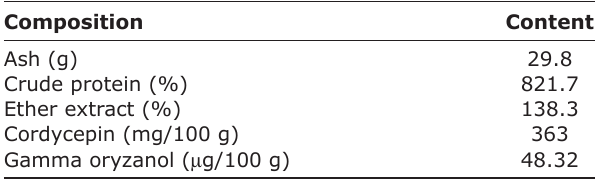
Table-1: Nutrient and some active compounds in Cordyceps militaris spent mushroom substrate.